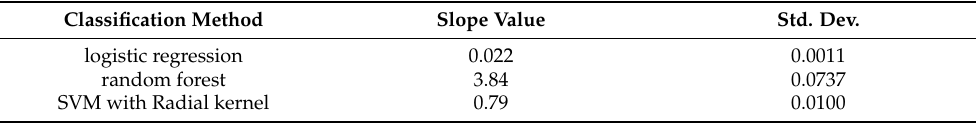
Table 10. The slope of the execution time versus the number of